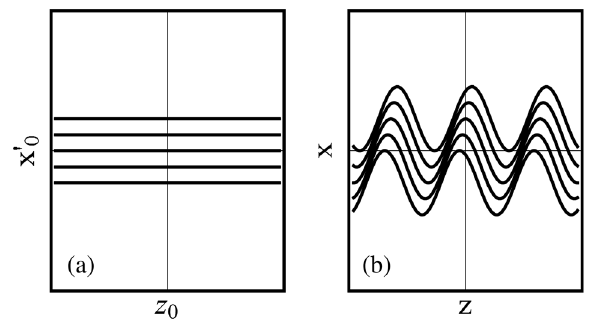
FIG. 1. A beam assumed for simplicity to have vanishing horizontal width ( x 0 ¼ 0 ) but finite angular spread, uniform density in z 0 , and carrying a small energy modulation, is represented here as a set of five uniform charge lines in the z =x 0 0 0 plane (left). The beam will exhibit longitudinal/transverse microbunching (right) as it propagates through a dispersive transport line (lumping of charge along diagonal